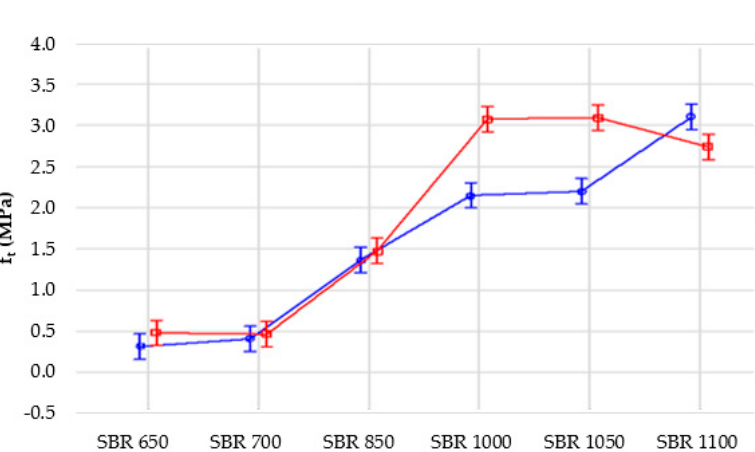
Figure 11. Influence of density on tensile strength of the samples for two analyzed conditions: blue line—1 (normal conditions), red line—2 (ageing conditions).